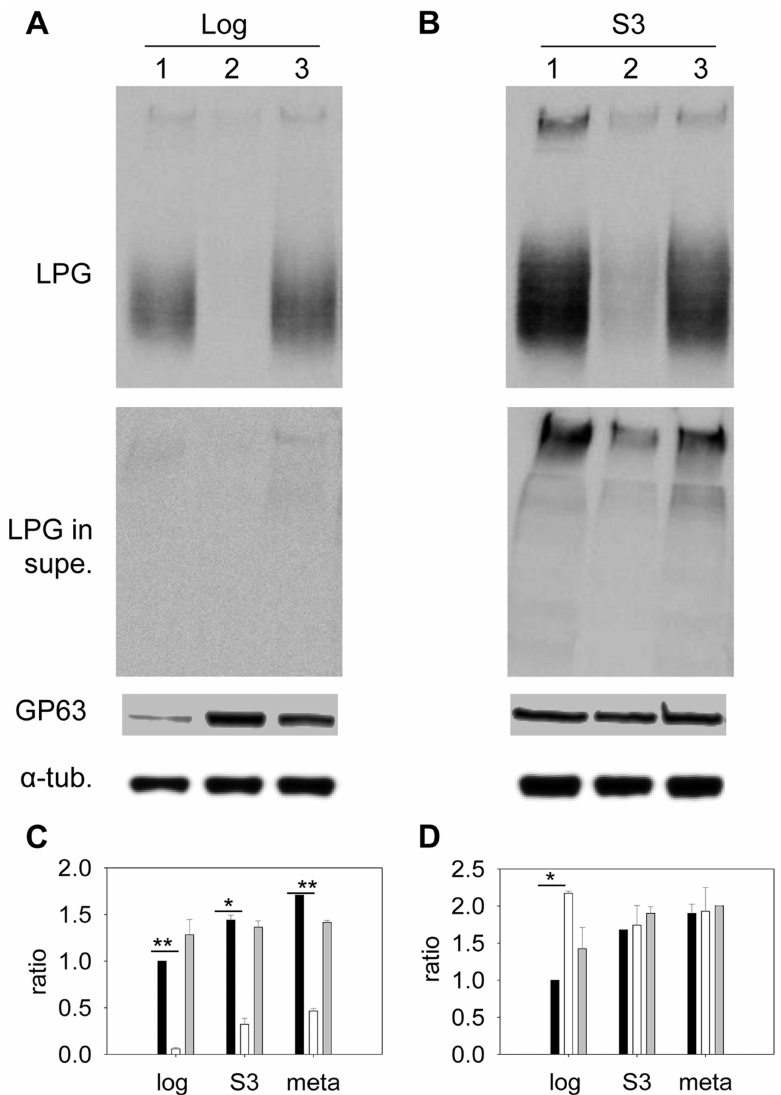
Figure 6. Altered expression of LPG and GP63 in c14dm 2 mutants. ( A – B ) Whole cell lysates or culture supernatants (LPG in supe.) from log phase ( A ) or day 3 stationary phase ( B ) promastigotes (lane 1: WT, lane 2: c14dm 2 , lane 3: c14dm 2 / + C14DM ) were analyzed by Western blot, using antibodies against LPG, GP63, or a -tubulin. ( C – D ) The relative abundance of LPG ( C ) and GP63 ( D ) was normalized in log phase, stationary phase, and metacyclic parasites (black bars: WT; white bars: c14dm 2 ; grey bars: c14dm 2 / + C14DM ). Error bars represent standard deviations from 3 experiments (*: p , 0.05, **: p , 0.01).